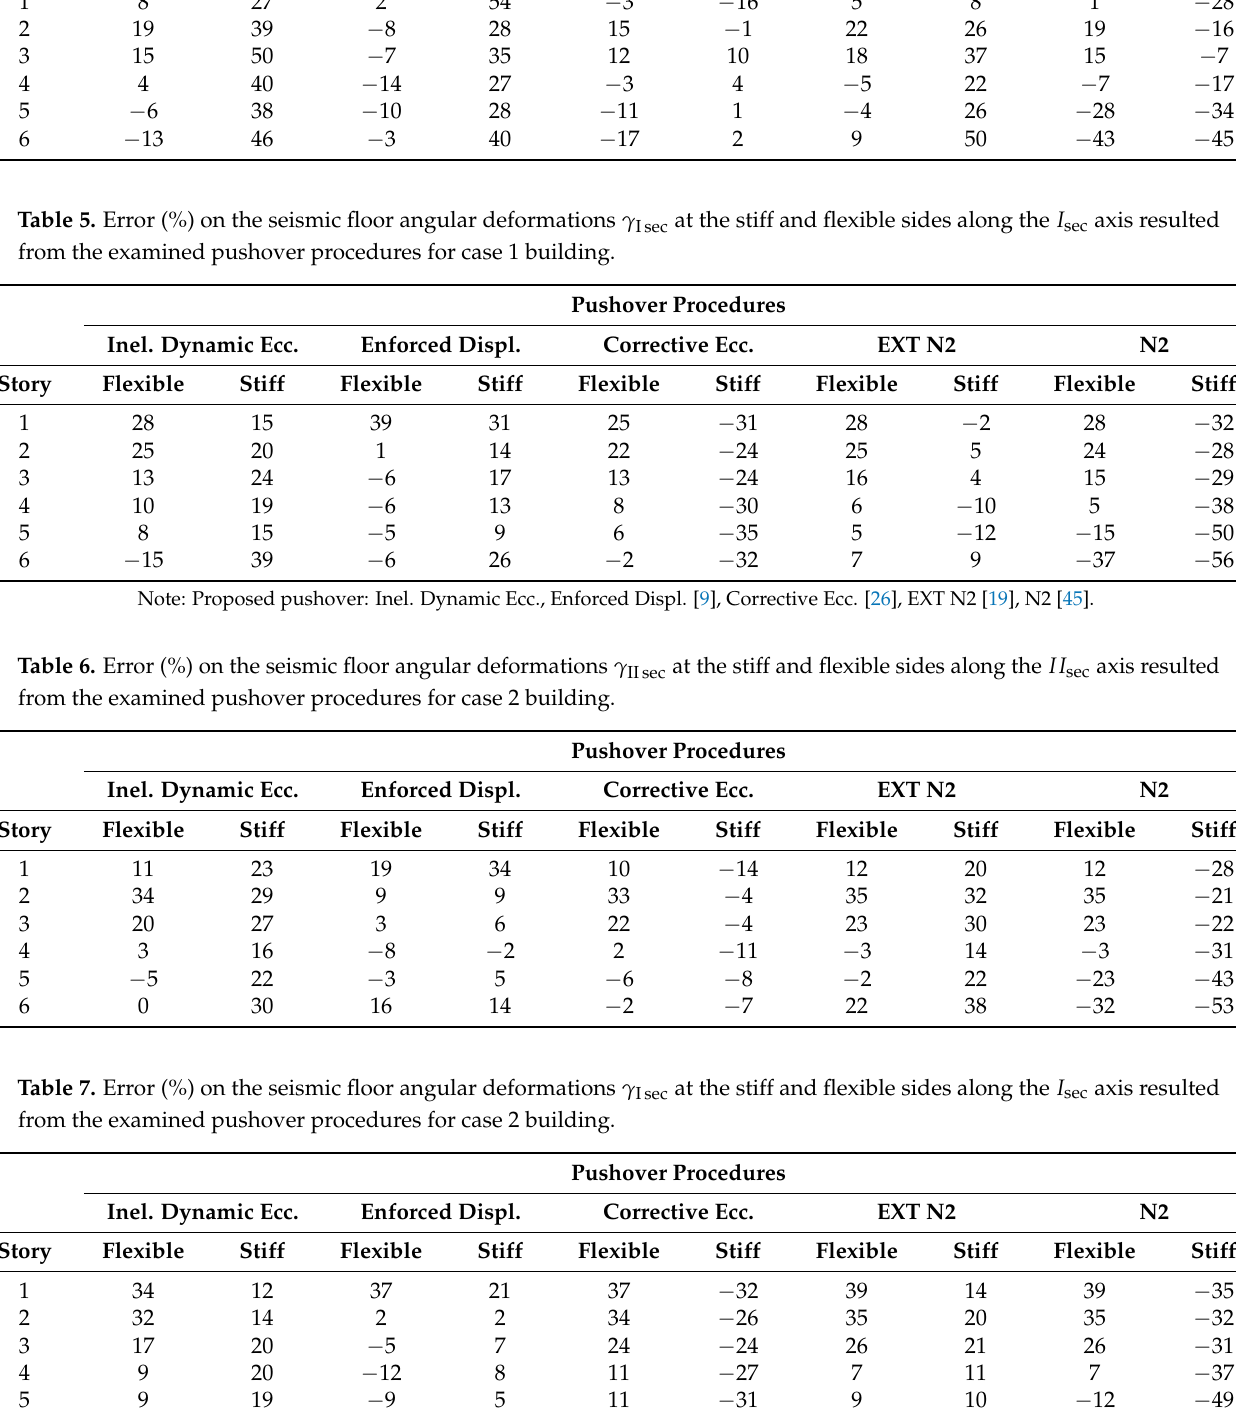
Inel. Dynamic Ecc.